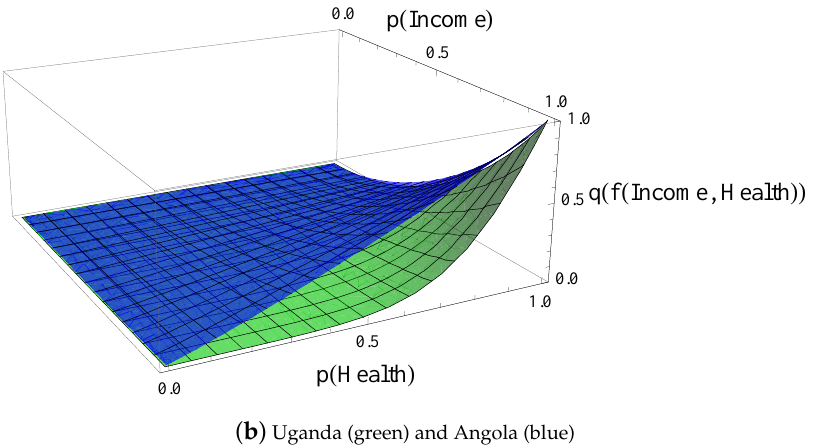
Figure 1. Bivariate Lorenz surfaces: evolution of multidimensional inequality in wealth and health. The curves are defined by Equation (14) with components defined in Equations (20) and